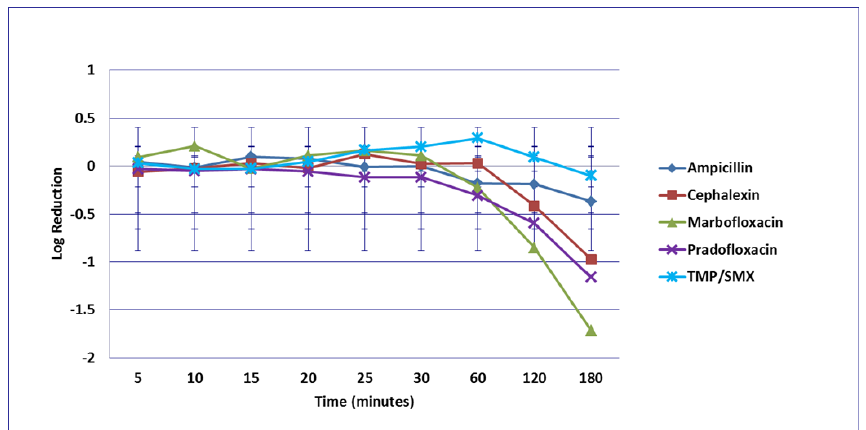
Figure 8. Log 10 reduction in E. faecalis with bacterial cells exposed to ampicillin, cephalexin, mar- bofloxacin, pradofloxacin, and trimethoprim/sulfamethoxazole at the maximum urine drug concen- tration. Pradofloxacin vs. TMP/SMX at 60, 120, and 180 min, p values 0.0011, 0.0059, and 0.0004. Marbofloxacin vs. TMP/SMX at 60, 120, and 180 min, p values 0.0029, <0.0001, <0.0001. Data points present mean ± standard deviation.